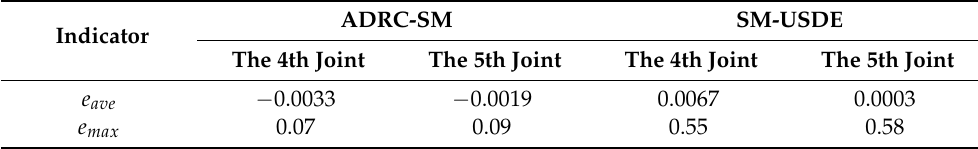
Figure 13. Experimental comparative result in group 2. Table 5. Comparison results of controller performance indicators.